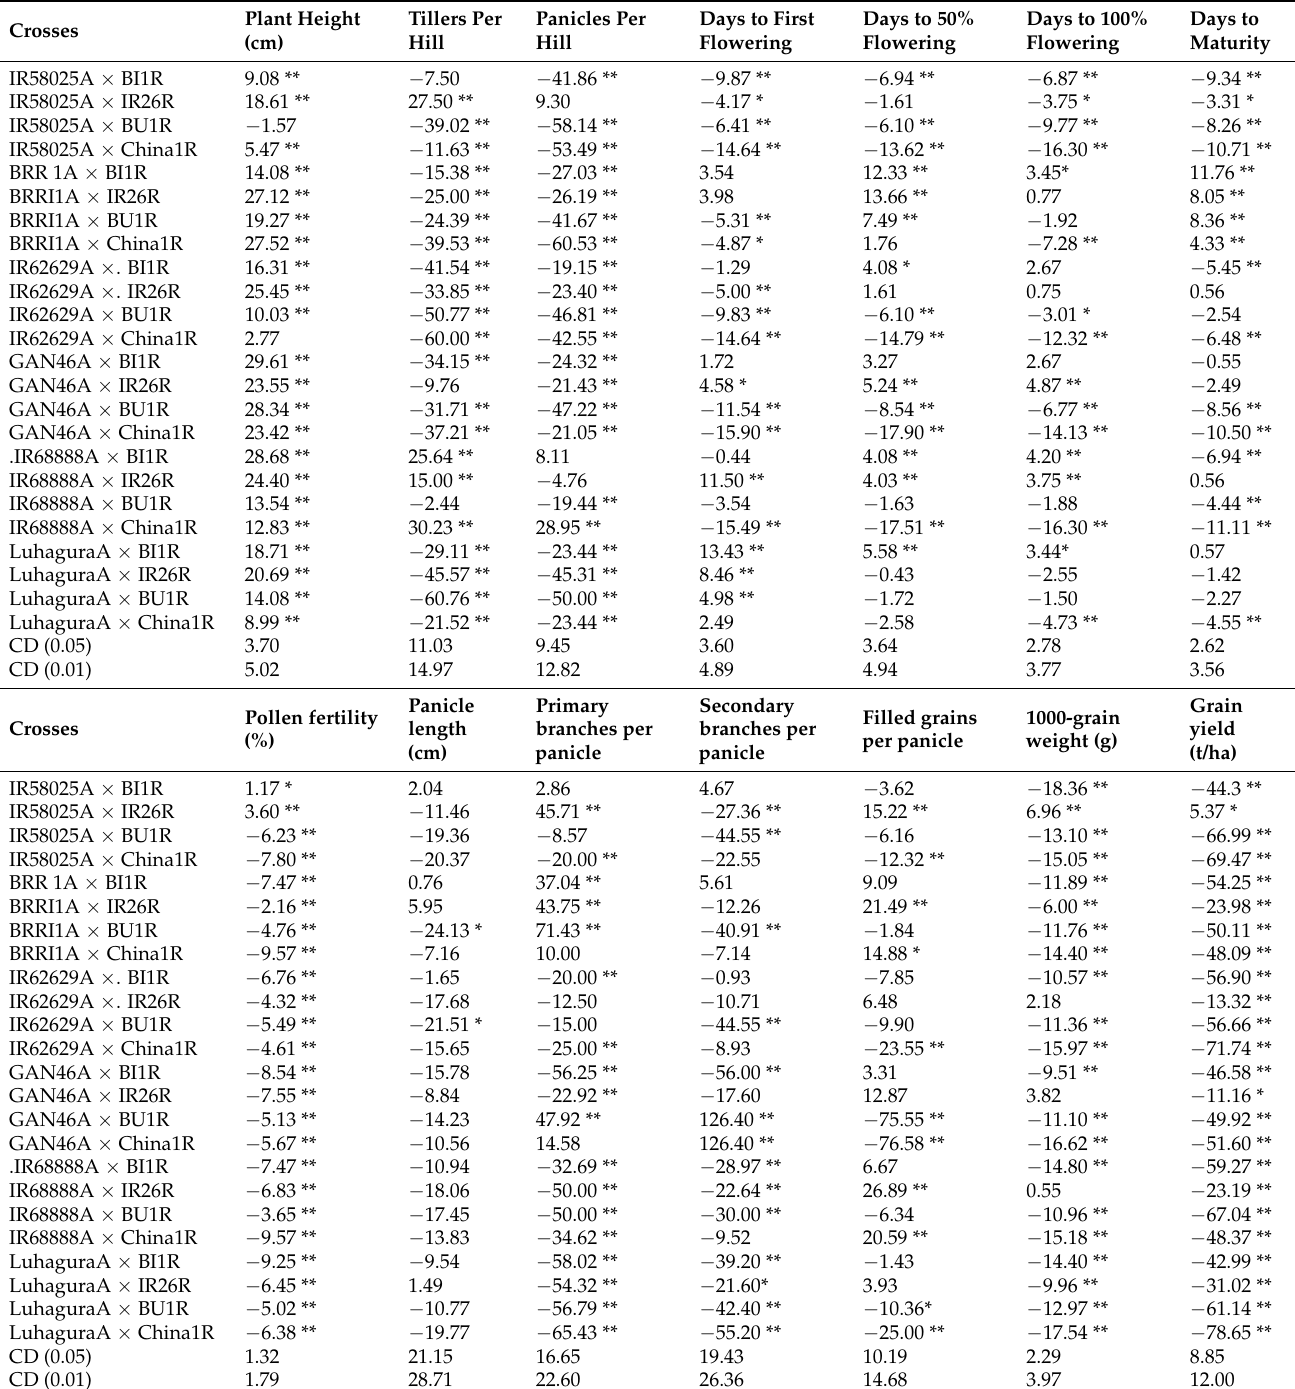
Table 6. Estimates of better parent heterosis (heterobeltiosis) of 24 crosses for yield and its contribut- ing